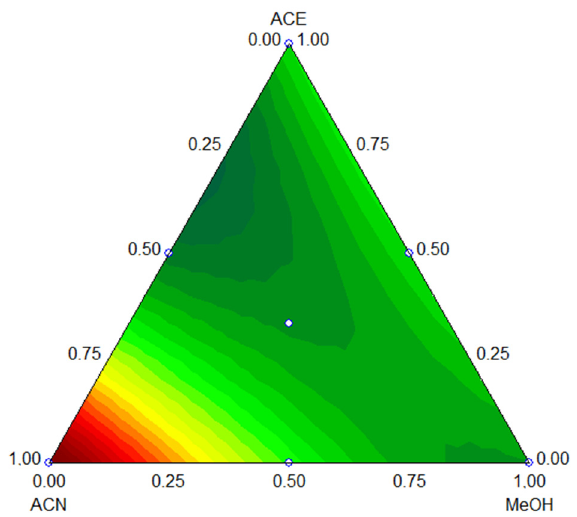
Figure 2. Triangular surface obtained for the evaluation of the desorption solvent. Extraction was performed with 20 mg of Si3Py + Cl − ; 100 μ g L − 1 of each analyte, five extraction cycles with 800 μ L of sample in each cycle and 15 s of extraction time; and five desorption cycles with 100 μ L of each solvent and/or mixture of solvents and 15 s of desorption time.